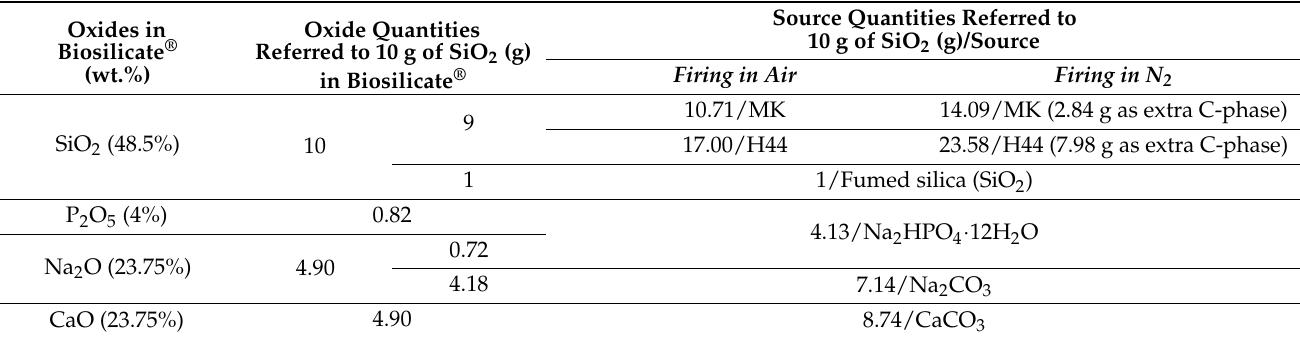
Table 2. Batch formulations for polymer-derived Biosilicate scaffolds based on H44 and anhydrous sodium phosphate (processed by DIW). Oxides in Biosilicate ®